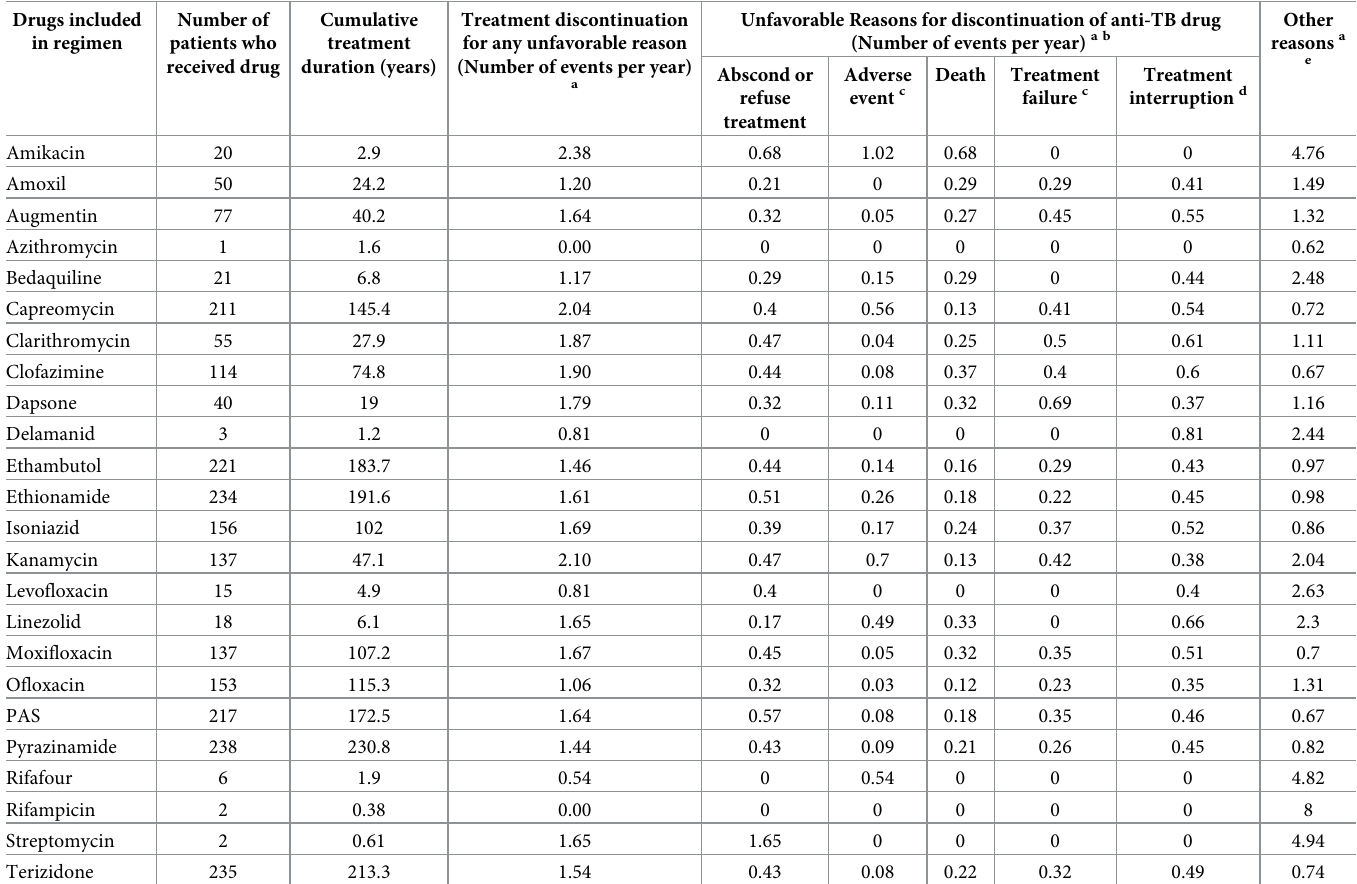
Table 3. Reasons for discontinuation of anti-TB drugs. Unfavorable reasons drug-resistant tuberculosis patients discontinued anti-tuberculosis drugs while hospitalized as reported in medical records. Drugs included in